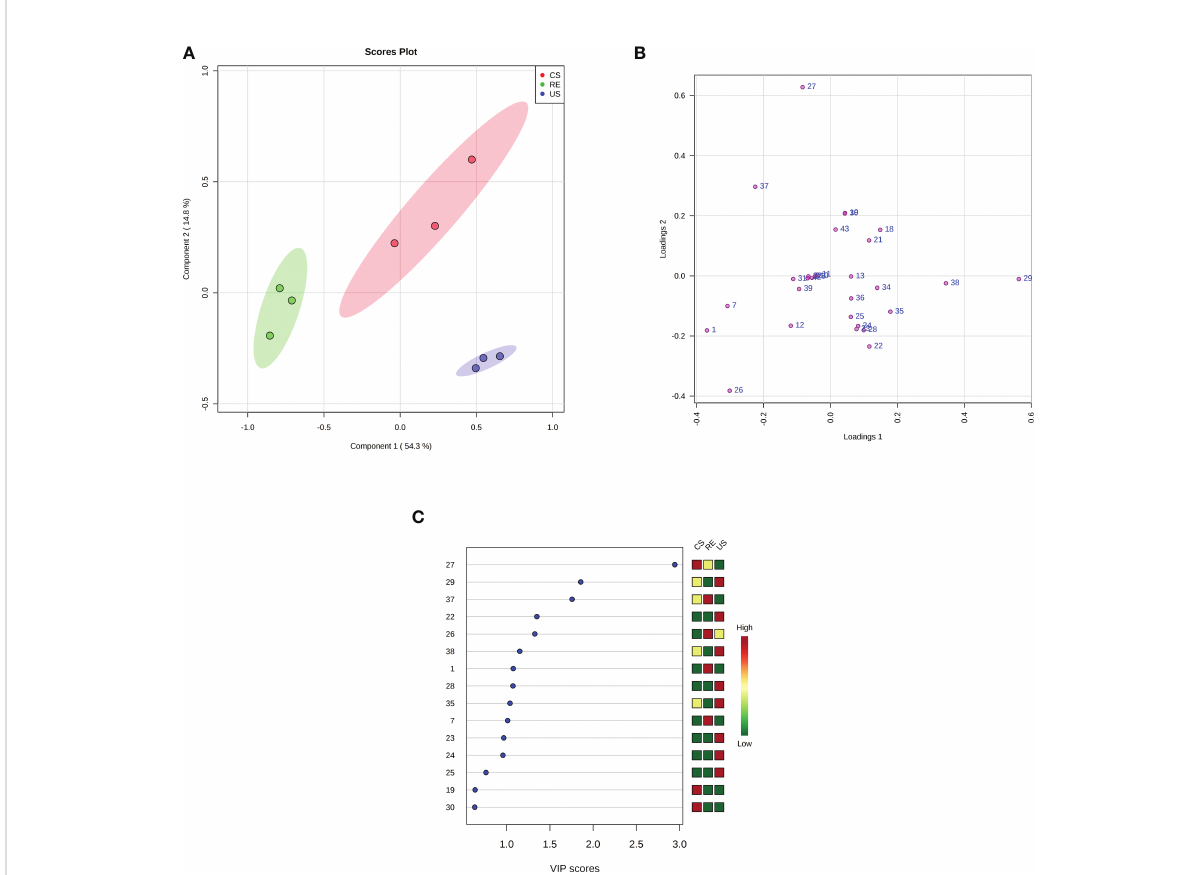
FIGURE 5 Multivariate analysis using PLS-DA. (A) PLS-DA score plots. The explained variances are shown in brackets; (B) PLS-DA loadings plot. The numbers in the loading plot of all the samples correspond to the Peak ID provided in Table 3; (C) Important features identi fi ed by PLS-DA. The colored boxes on the right indicate the relative concentrations of the corresponding metabolite in each group under study. The numbers on the left correspond to the Peak ID provided in Table